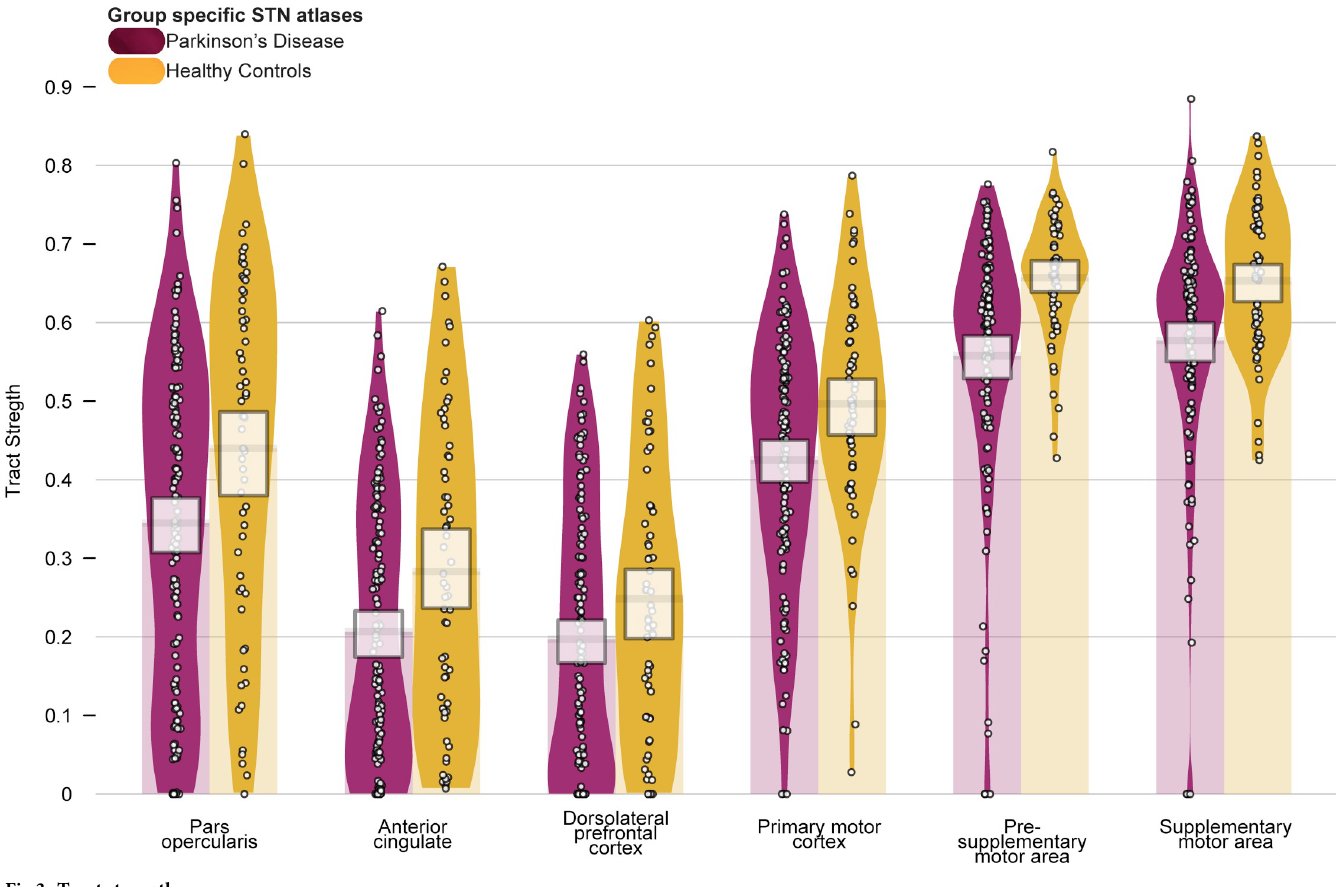
Fig 3. Tract strengths.